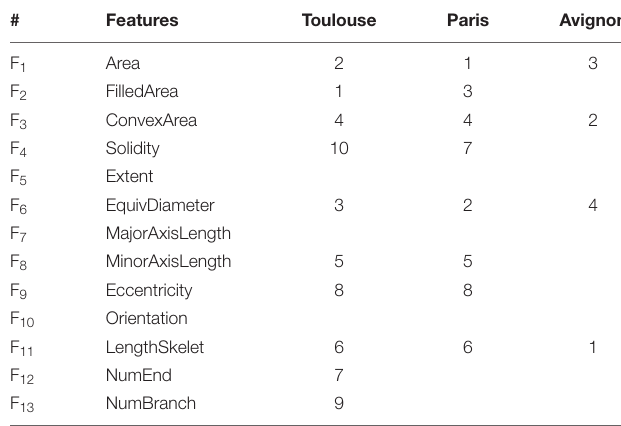
TABLE 4 | Features selected and the corresponding rank over three